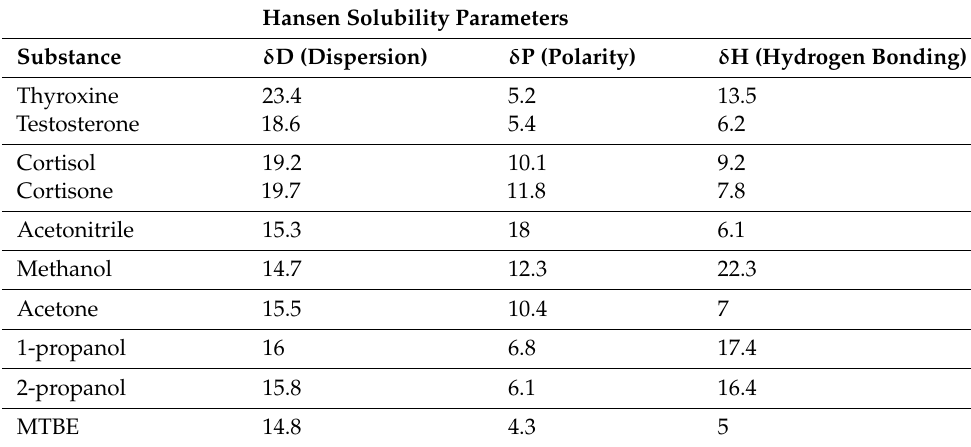
Table 4. Hansen solubility parameters for solvents and hormones